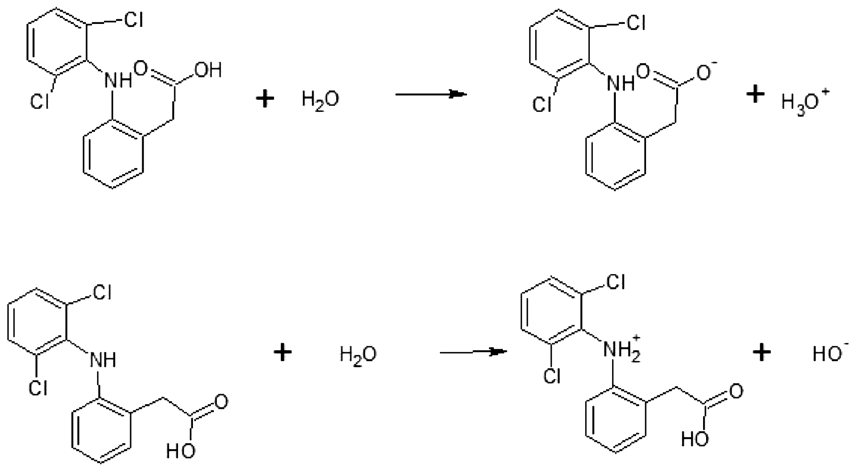
Figure 6. Equilibrium dissociation of